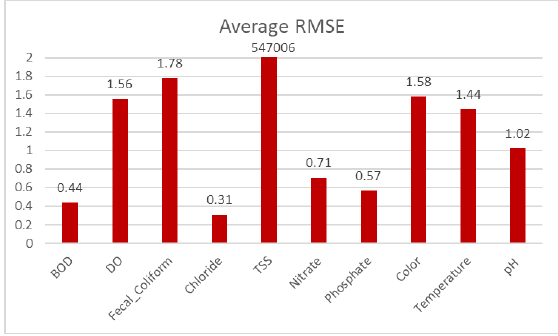
Figure 5. Average RMSE per water quality model Based from the RMSE values in figure 5, it is observed that the Chloride (0.31), BOD (0.44), Phosphate (0.57) and Nitrate (0.71) models has the least amount of discrepancy in terms